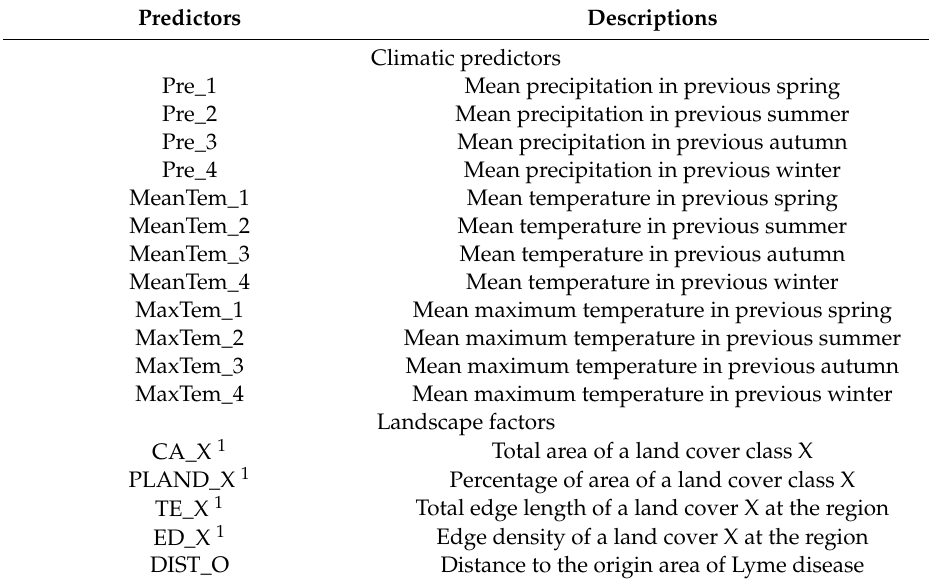
Table 1. Description of climatic and landscape factors used in this